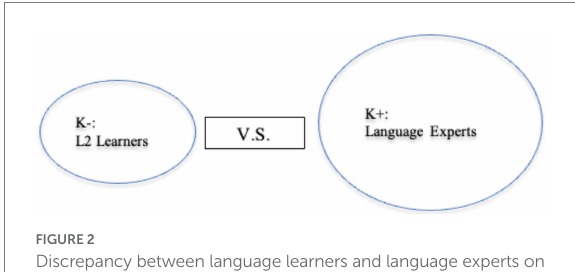
FIGURE 2 Discrepancy between language learners and language experts on the target language